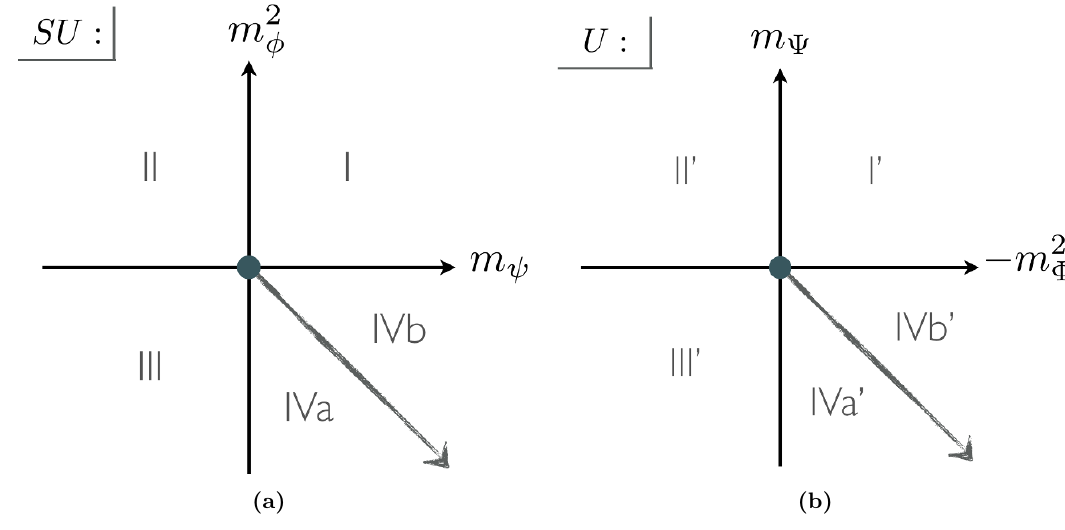
Chern-Simons theory (cid:0) k + Nf 2 Chern-Simons theory coupled to N s N (cid:0) N s 2